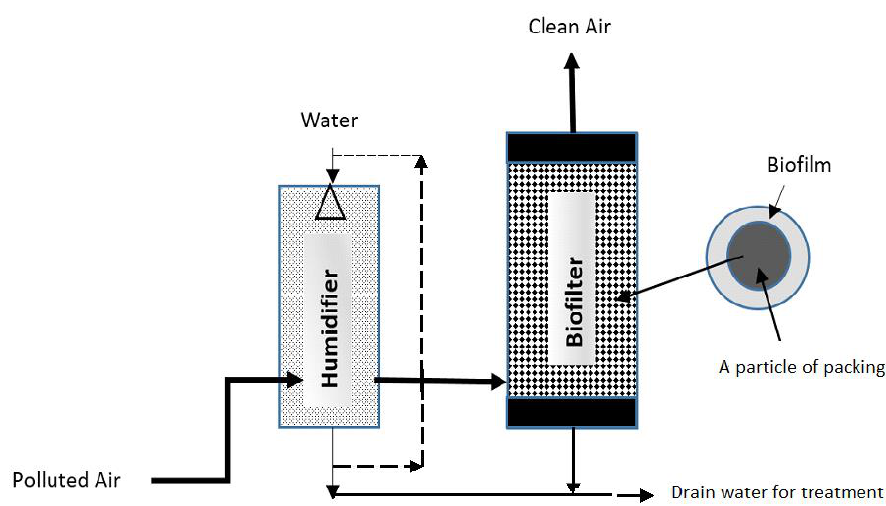
Figure 1. A simplified diagram of the biofilter process.